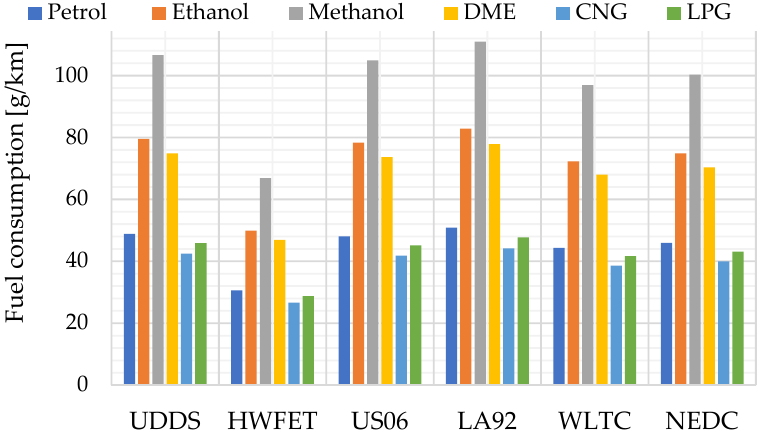
Figure 13. Summary of the final consumption of tested fuels per kilometer of travelled road obtained from the simulation of the 2018 Toyota Camry LE vehicle for selected road tests.